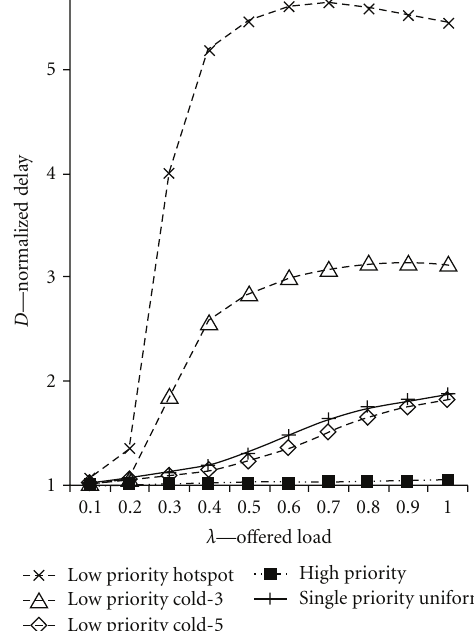
Figure 5: Normalized delay of a dual-priority, double-bu ff ered, 6- stage MIN under hotspot tra ffi c at a single-layer